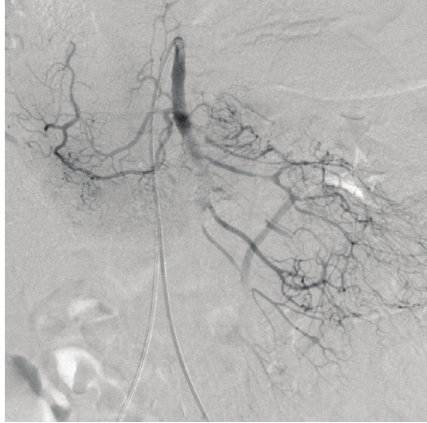
Figure 3: Angiography of the SMA after stent placement shows improved peripheral blood flow